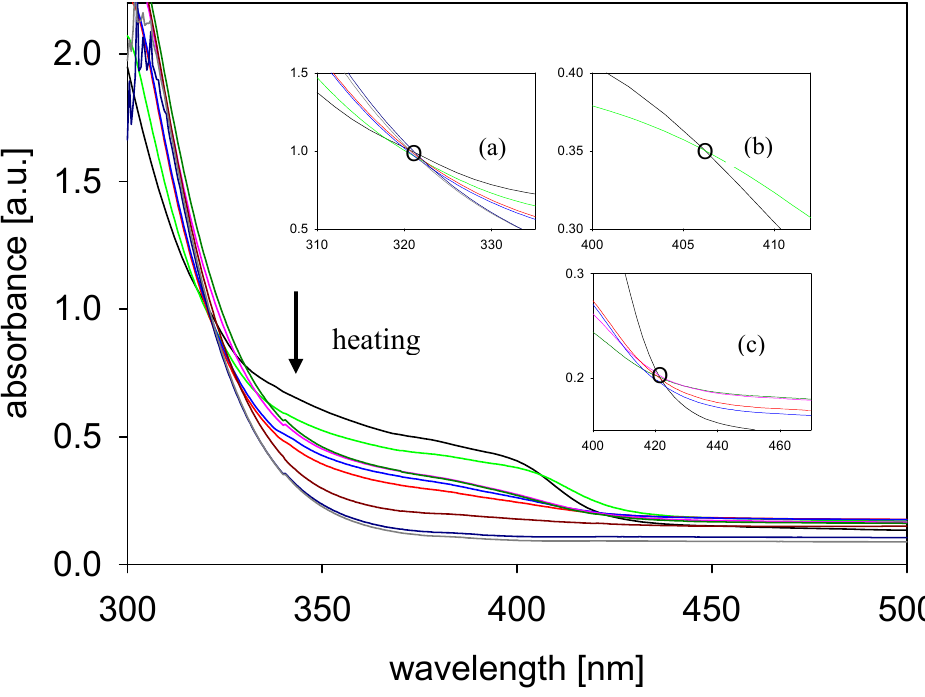
Figure 10. Temperature dependence of UV-vis spectra of the A2 at the following temperatures: 25, 70, 150, 155, 185; 200, 215, 230, 237 ° C. Insets: (a) The isosbestic point at 322 nm (for the curves crossed at the following temperatures 25, 70, 150, 155, 230, 237 ° C), (b) The isosbestic point at 406 nm (25 and 70 ° C) and (c) The isosbestic point at 420 nm (25, 150, 155, 185, 200 °